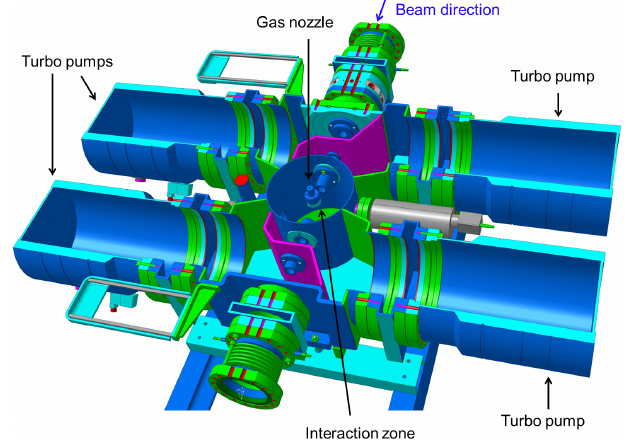
FIG. 2. Gas stripper box with enlarged beam aperture and two times higher pumping speed [20].